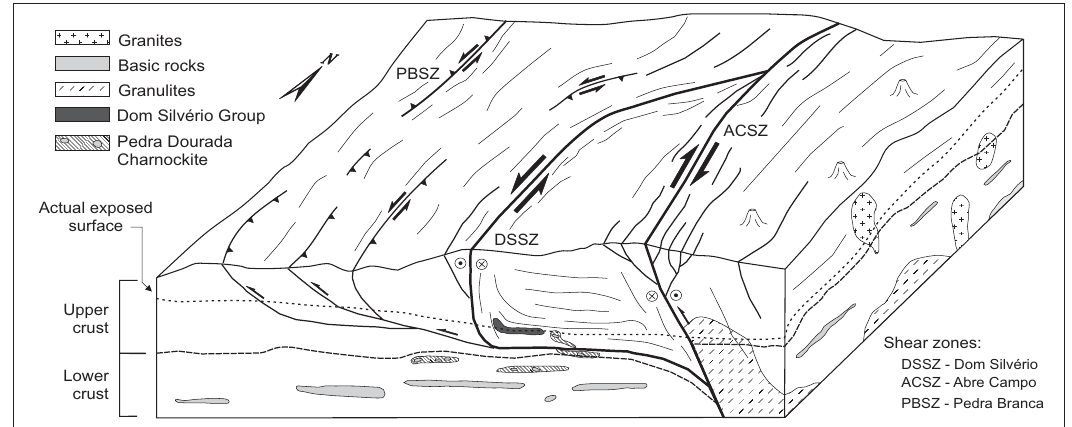
Fig. 10 – Model for the tectonic evolution of the southern portion of the Araçuaí belt during D 1 phase.